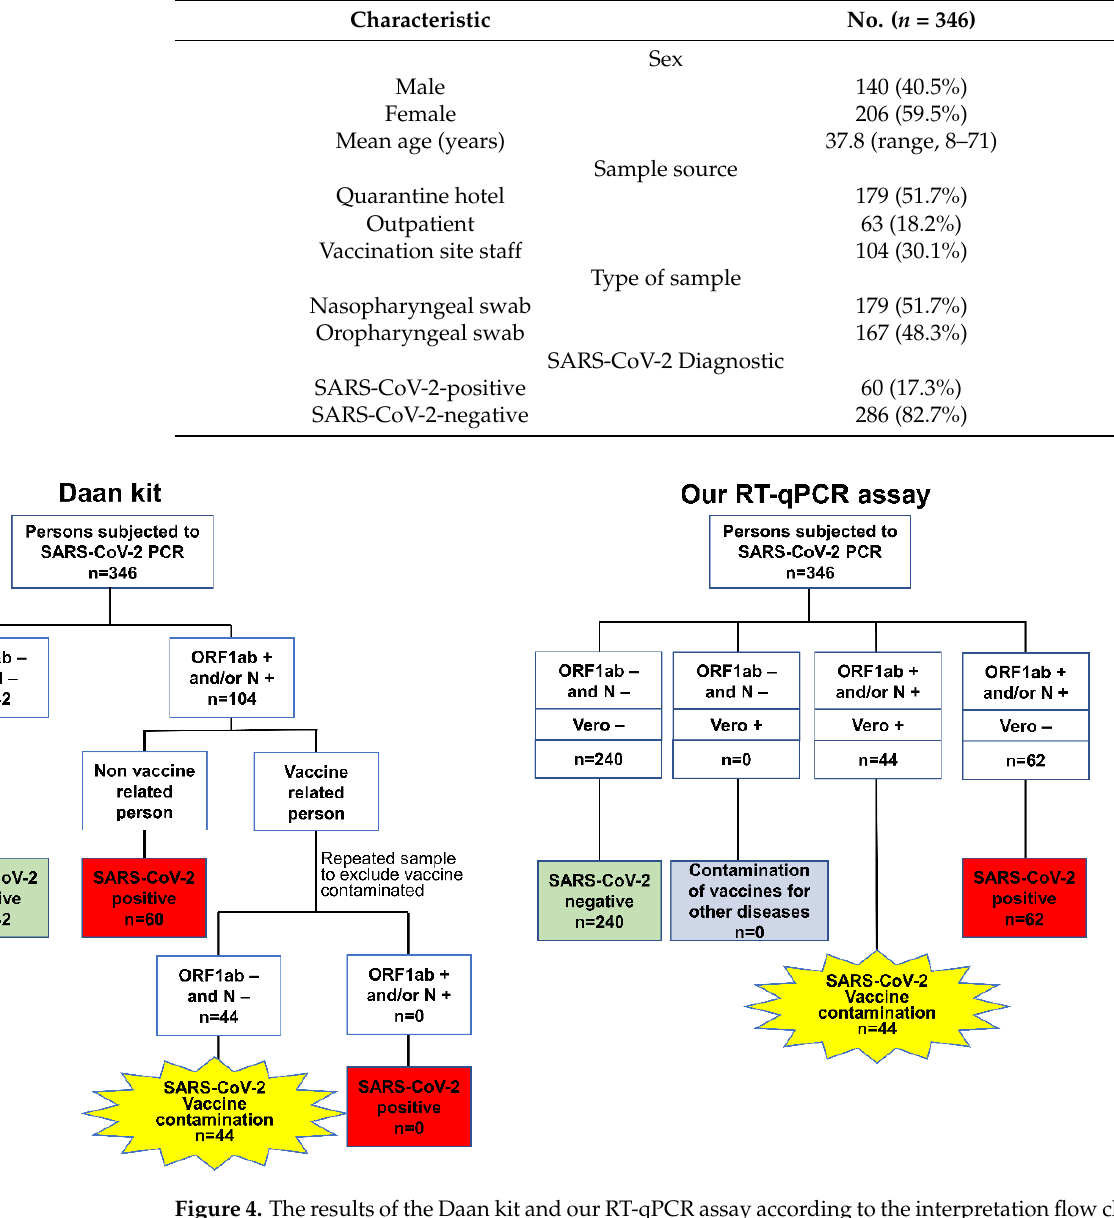
Table 2. Clinical data of 346 clinical samples.